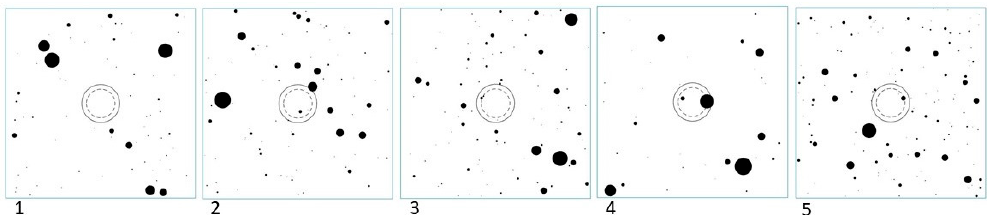
Figure 5. Five of the 500 configurations generated with the Matlab code. Different block sizes and positions are shown. Table 2. Probability, P, of encountering n blocks (with n from zero to more than seven) with an intersection area greater than the threshold value A_thr1, equal to 0.0177 m 2 . The average number of blocks corresponding to each equivalent clast diameter is also provided. The results are related to the entire tunnel section (table above) and to the circular crown (table below). These results are contained in the output text files “Probability” and “N_Average” of Table 3.